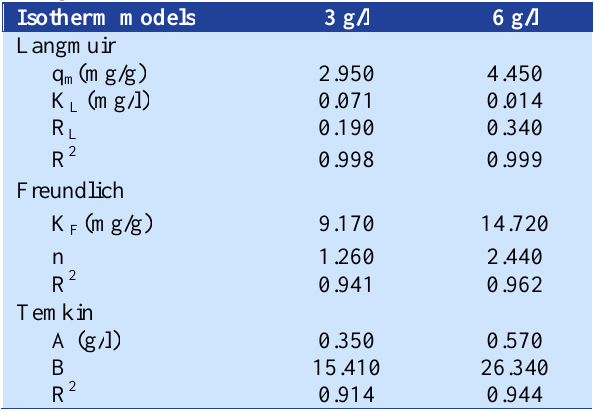
Table 1. Adsorption isotherm constants for the adsorption of Cr (VI) onto canola at two biomass dosages Isotherm